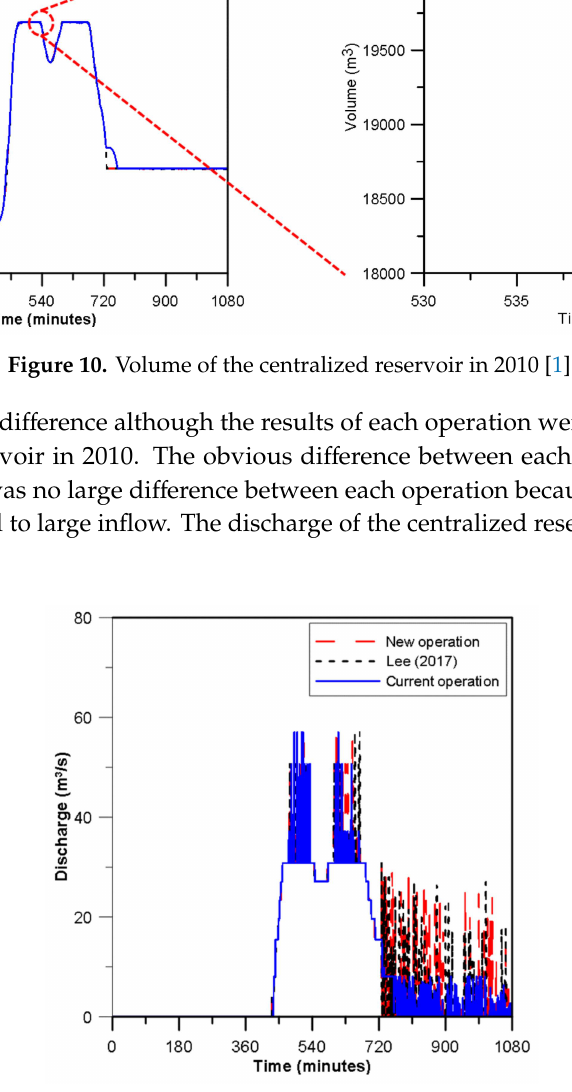
Figure 11. Discharge of the centralized reservoir in 2010